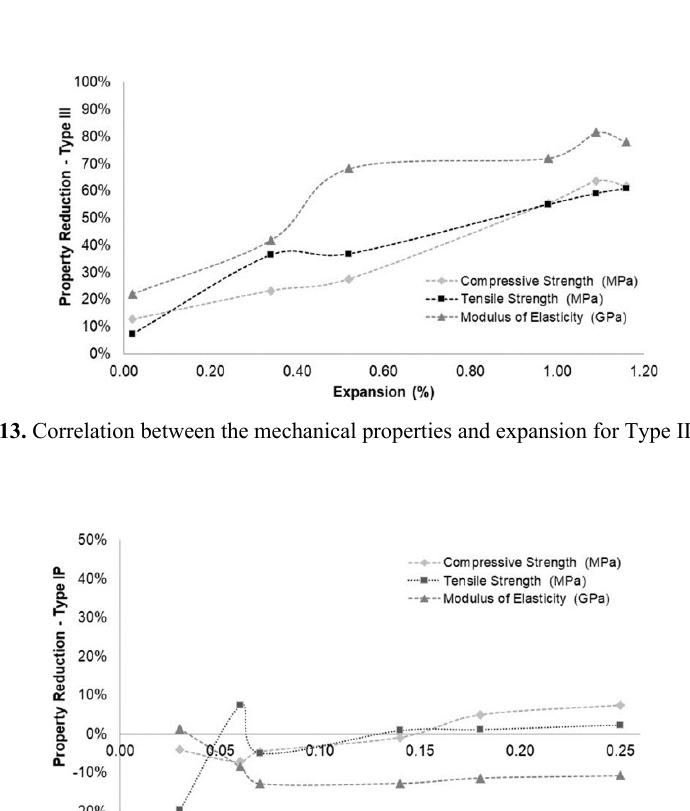
Figure 12. Relationship between modulus of elasticity versus expansion.